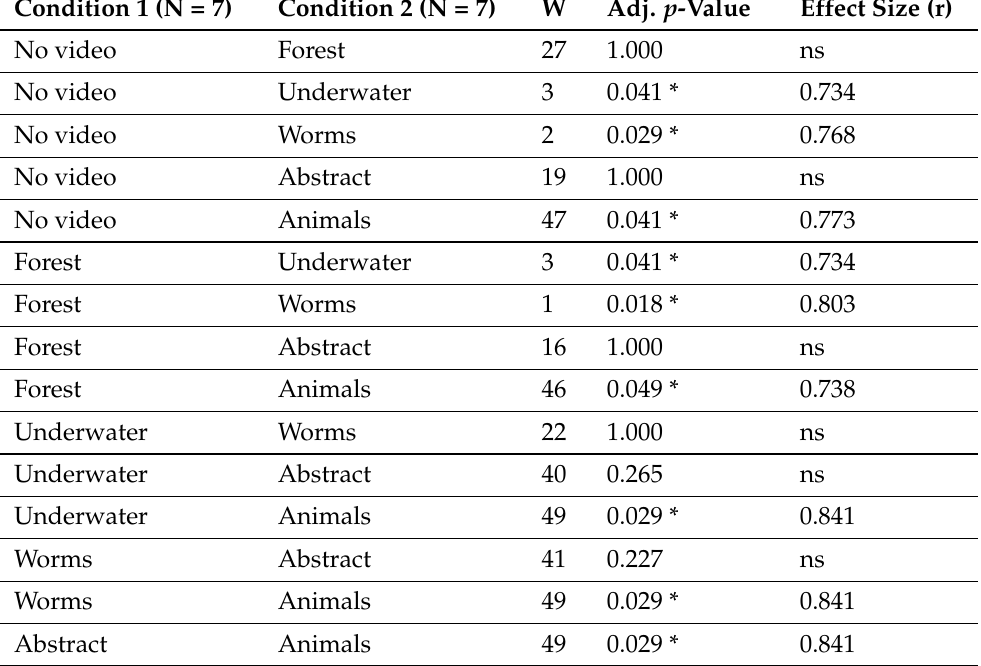
Table 3. Wilcoxon rank-sum test results and effect size for total use time per day per monkey, * <0.05. Condition 1 (N =